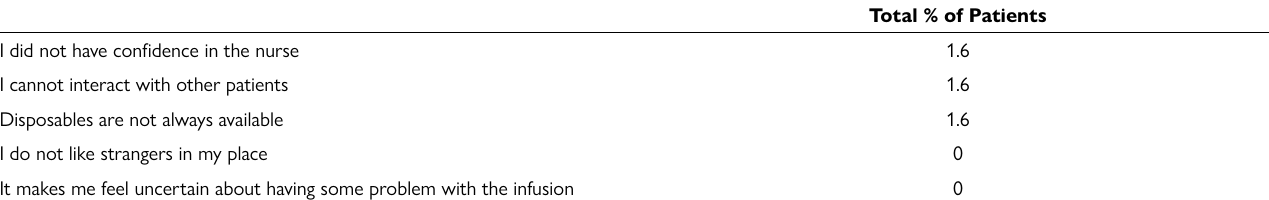
Table 5. Negative aspects of home